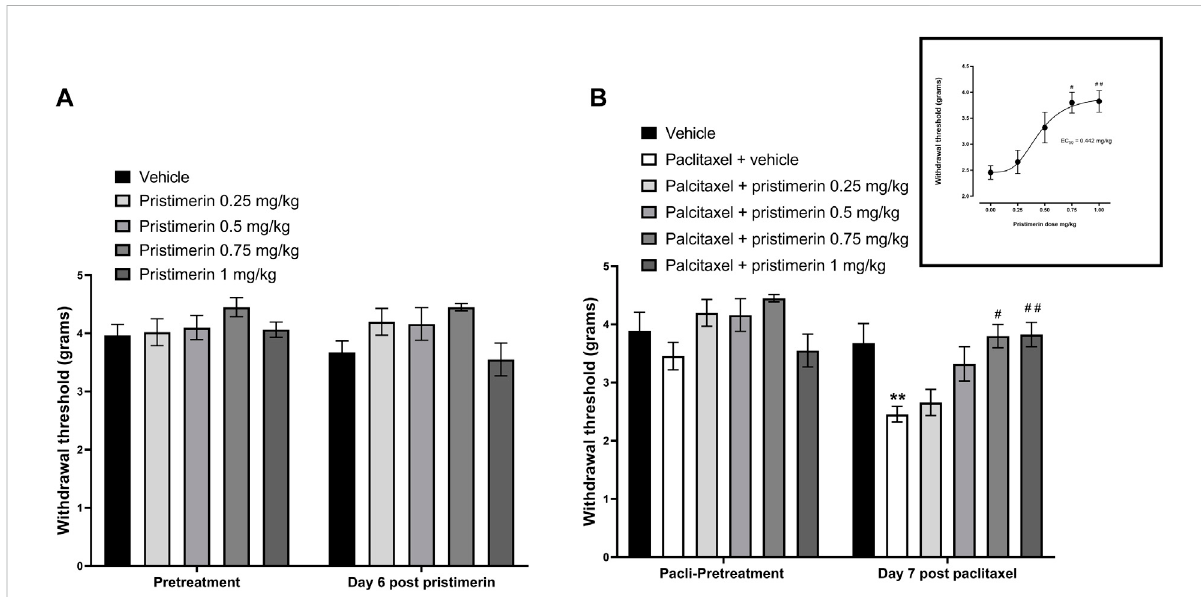
FIGURE 5 Pristimerin prevents the development of paclitaxel-induced mechanical allodynia in female BALB/c mice. (A) The effect of treatment of naïve mice with pristimerin on response to mechanical stimuli. Each bar represents the mean ± SEM of values obtained from four to eighteen animals. (B) Theeffectoftreatmentwithpristimerinonthedevelopmentofpaclitaxel-inducedmechanicalallodyniaatday7post- fi rstinjection(dpi)ofpaclitaxel. Eachbarrepresents themean±SEMofvaluesobtained fromfourto nineanimals.** p < 0.01 compared topretreatmentvalues(Mann-Whitney test), and # p < 0.05, ## p < 0.01 compared to mice treated with paclitaxel + vehicle (two-way repeated measures ANOVA followed by Tukey ’ s multiple comparisons test and for the insert Kruskal-Wallis test followed by Dunn ’ s multiple comparisons